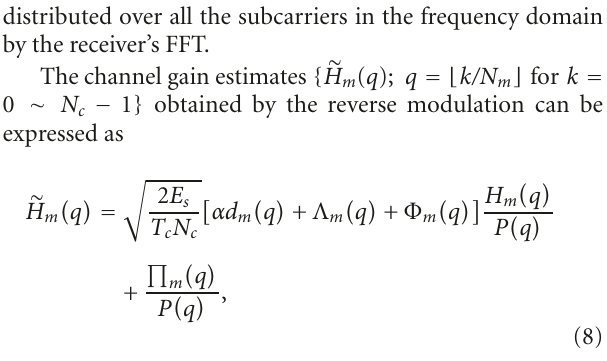
distributed over all the subcarriers in the frequency domain by the receiver’s